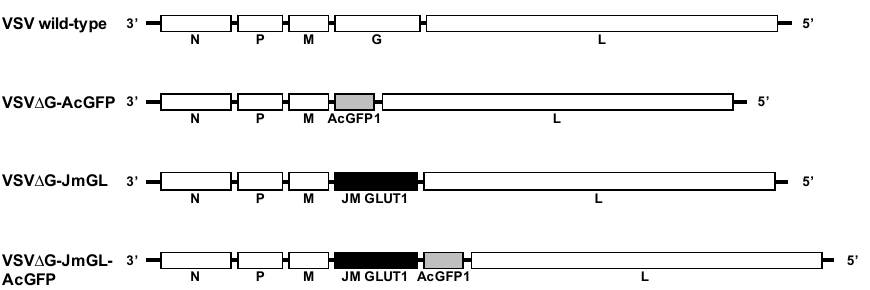
Figure 1. Schematic showing the structure of rVSVs expressing an STLV-1 receptor molecule and AcGFP1 as a reporter protein. The gene orders in the wildtype VSV and the rVSV constructs used in this study are illustrated. The deleted G gene was replaced with the JM GLUT1 or AcGFP1 genes, yielding the VSV ∆ G-JmGL or VSV ∆ G-AcGFP constructs, respectively. In addition, a JM GLUT1 gene was inserted upstream of the AcGFP1 gene in VSV ∆ G-AcGFP, yielding VSV ∆ G-JmGL-AcGFP. 3.2. Cell Surface Expression of the STLV-1 Receptor Molecule Encoded in the rVSV Genome